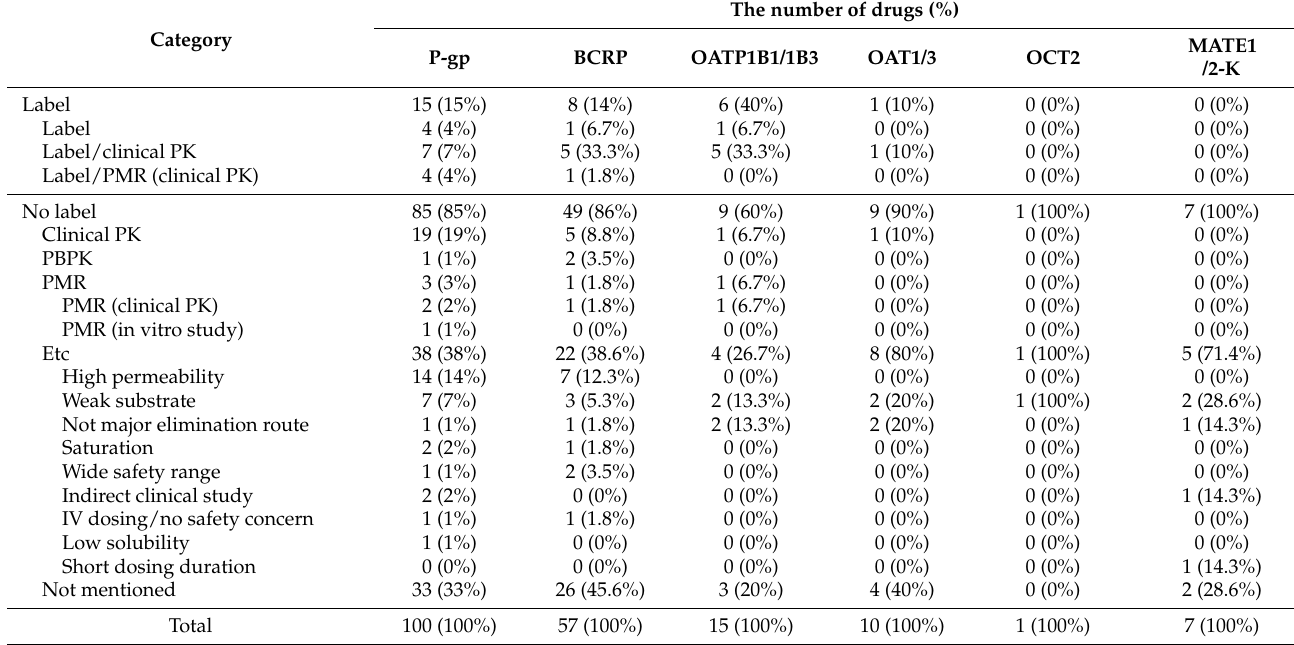
Table 5. Follow-up actions for in vitro transporter